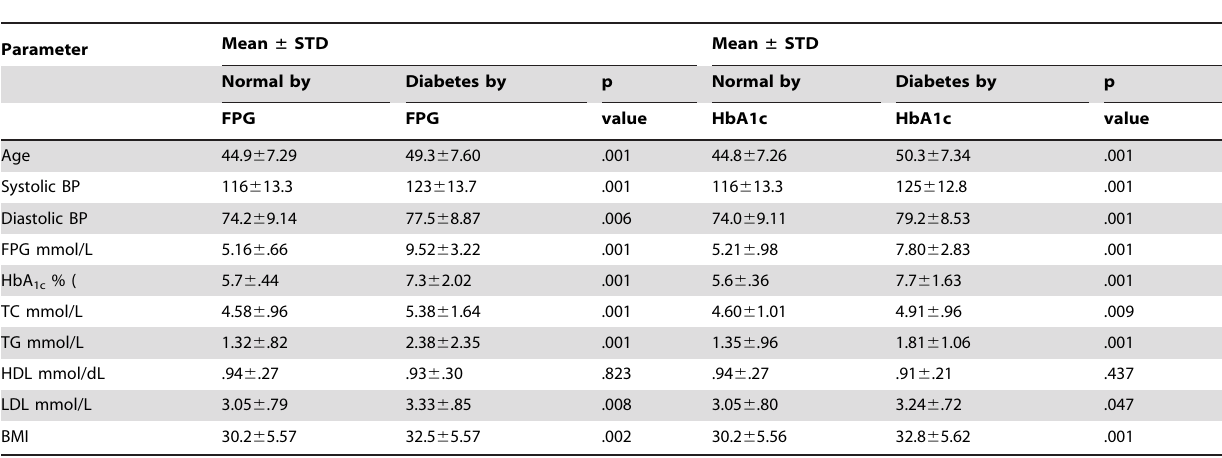
Table 2. The difference between mean values of measured parameters between subjects with diabetes vs. normal subjects according to FPG and HbA 1c